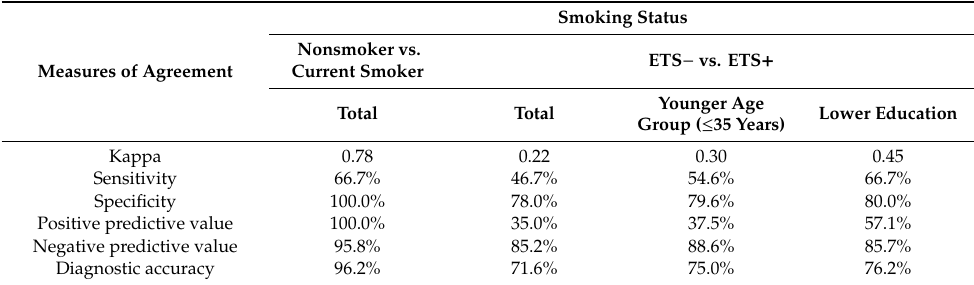
Table 3. Measures of agreement to determine the accuracy of self-reported smoking status and exposure to ETS with the urine cotinine analysis in the sample of pregnant women ( n = 80).